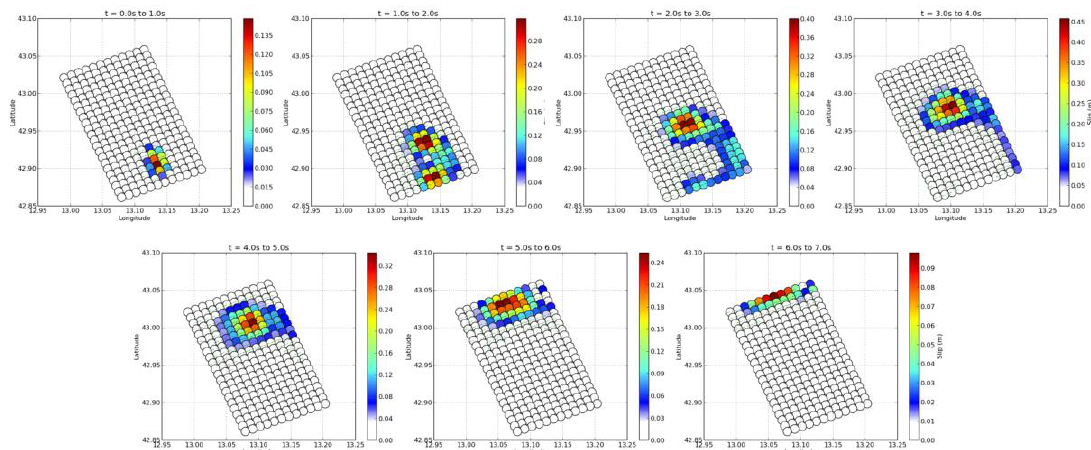
Figure A5. Rupture snapshots in a time interval of 1 s for the Visso earthquake.